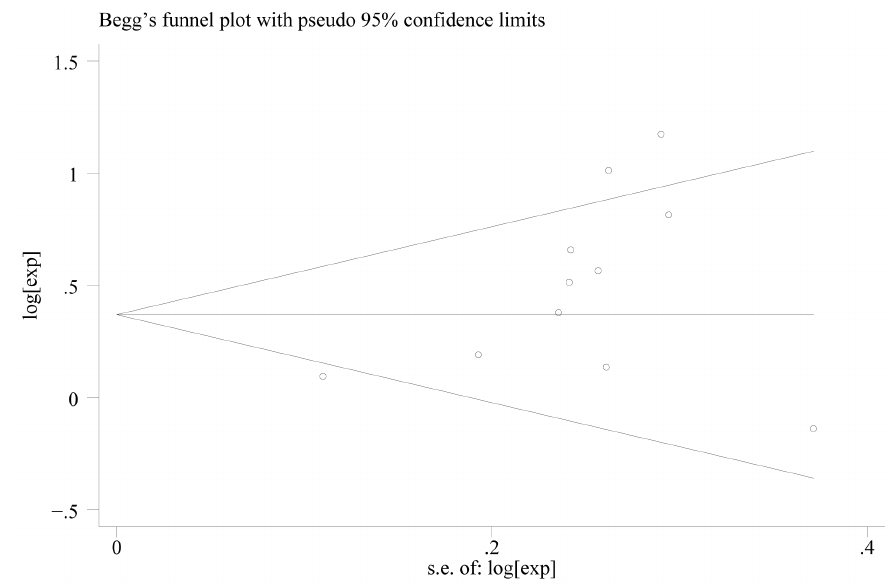
Figure 5. Begg’s test result of OS in Asian.